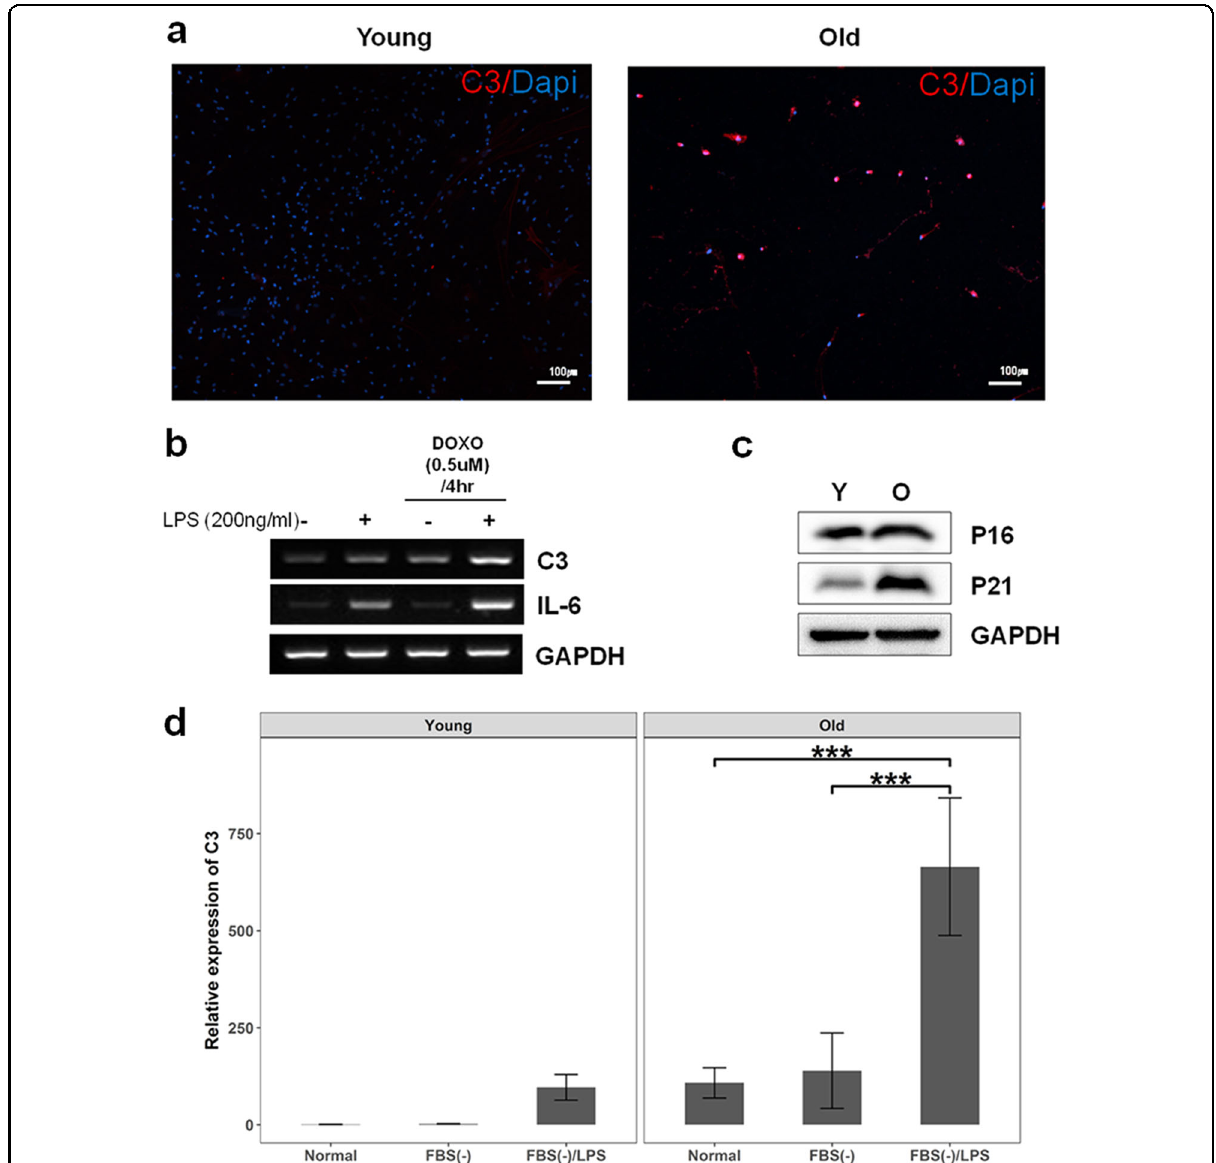
Fig. 7 Experimental validation of C3 expression in stem cells and primary cells. a Immunohistochemistry result showed that C3 positive cells in primary hippocampal cells were increased with age (Young: 8 weeks, Old: 25 months). b Cells pre-treated with DOXO displayed increased expression of C3 and IL-6 compared with control cells after LPS treatment. c Aged cells from placental stem cells were determined by increased expression of P21 (O: old, Y: young). d When depleted of FBS and treated with LPS, the aged placental stem cells showed dramatic increase compared to the young cells. Interaction effects between cell status (aged or young) and stress treatments (depletion of FBS and LPS treatment) were signi fi cant ( F 2, 24 = 22.96, p < 0.001). Data are expressed as mean ± SD. Scale bars: 100 μ m in a ,*** p < 0.001 for